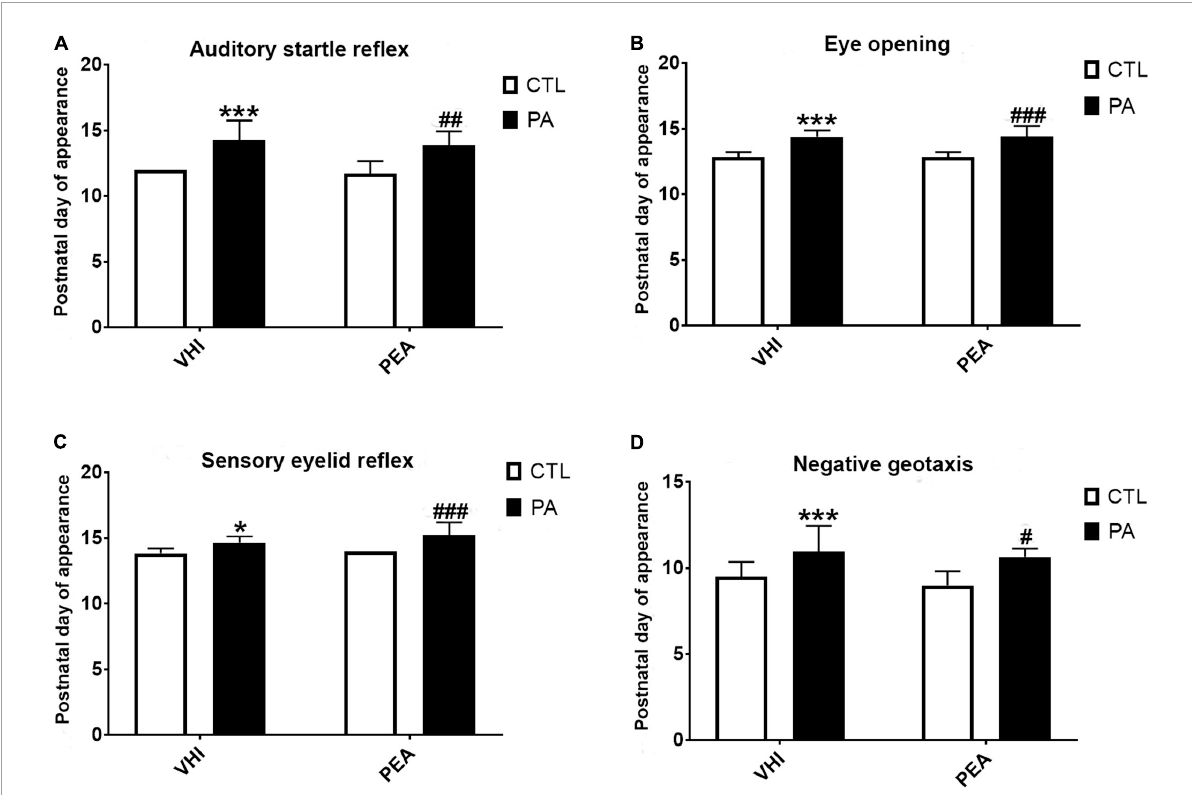
FIGURE5 Postnatal day of reflexes appearance and neurological signs. (A) Auditory start reflex. (B) Eye opening. (C) Sensory eyelid reflex. (D) Negative Geotaxis. Bars and error bars represent mean ± SEM. * p < 0.05, PA-VHI vs. CTL-VHI; *** p < 0.001, PA-VHI vs. CTL-VHI; # p < 0.05, PA + PEA vs. CTL-VHI; ## p < 0.01, PA + PEA vs. CTL-VHI; ### p < 0.001, PA + PEA vs. CTL-VHI. CTL-VHI, control rats treated with vehicle; PA-VHI, rats subjected to PA and treated with vehicle; PA + PEA, rats subjected to PA and treated with PEA; CTL + PEA, control rats treated with